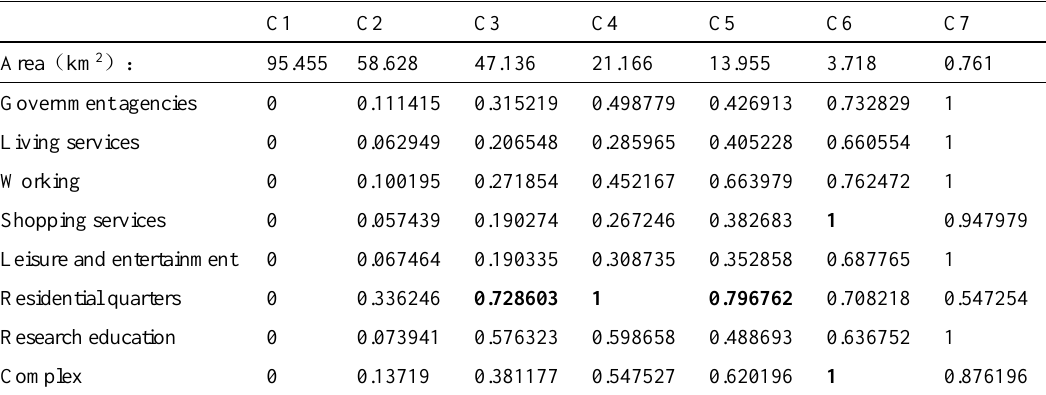
Table 4. POI standardized values of various plots (16: 00 ~ 19: 00 D) 4.3 Working days 22: 00 ~ 24: 00 Clustering results From the clustering results (Figure 4(A).) and the